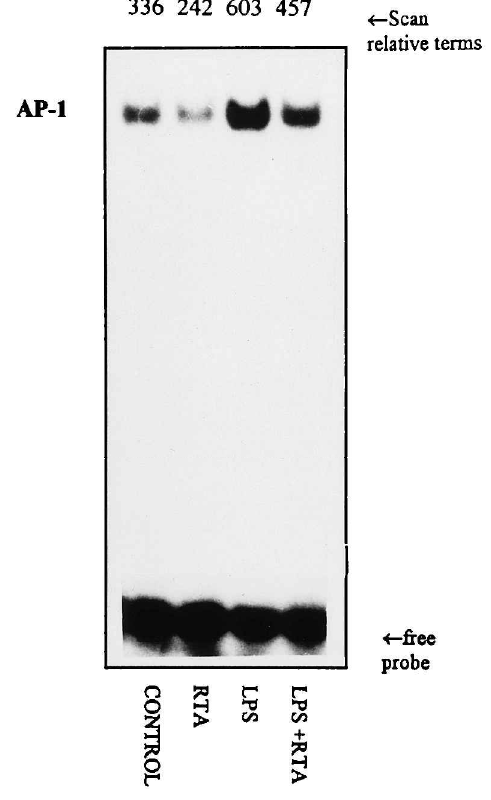
FIG. 6. Inhibition of AP-1 binding to DNA sequences following 60min RTA treatment or/and 60min exposure to LPS. Electrophoretic mobility shift assay of nuclear extracts isolated from control, RTA- (10 m M), LPS- (500ng/ml) or LPS+RTA- treated U937 cells primed with PMA. Cells were incubated for 60min with RTA, followed by an additional 60min with LPS and then nuclear extracts were isolated and processed as described in Materials and Methods. Densito- metric scans are expressed in arbitrary